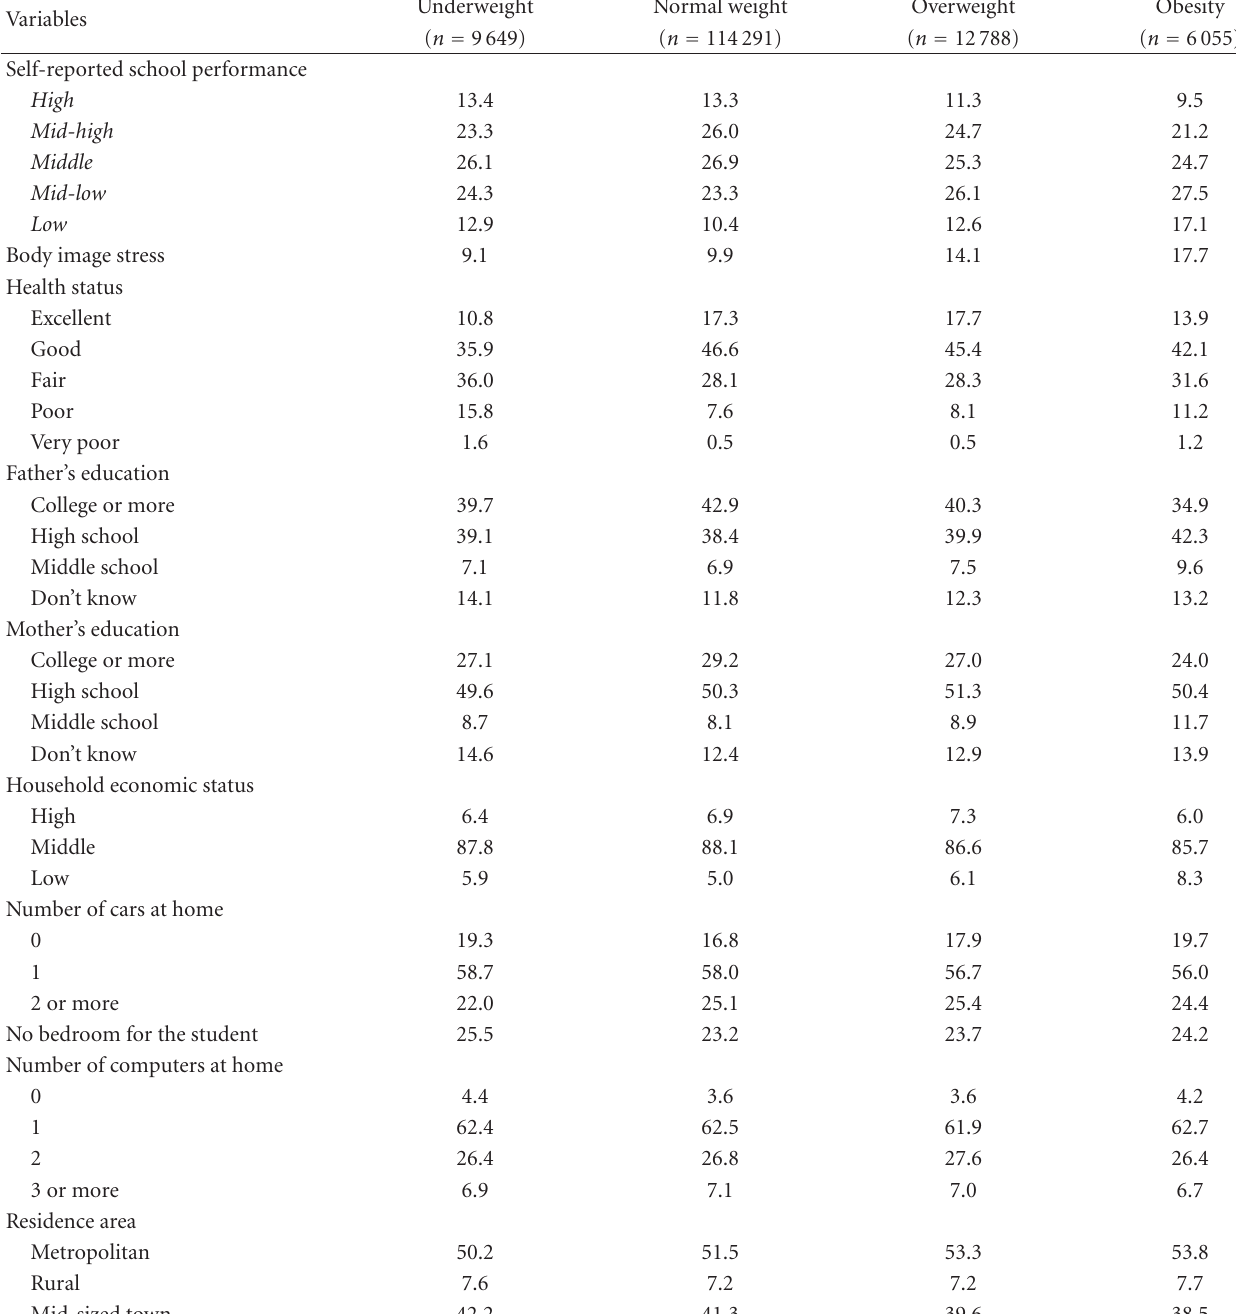
Table 1: Summary statistics of the study sample ( N =